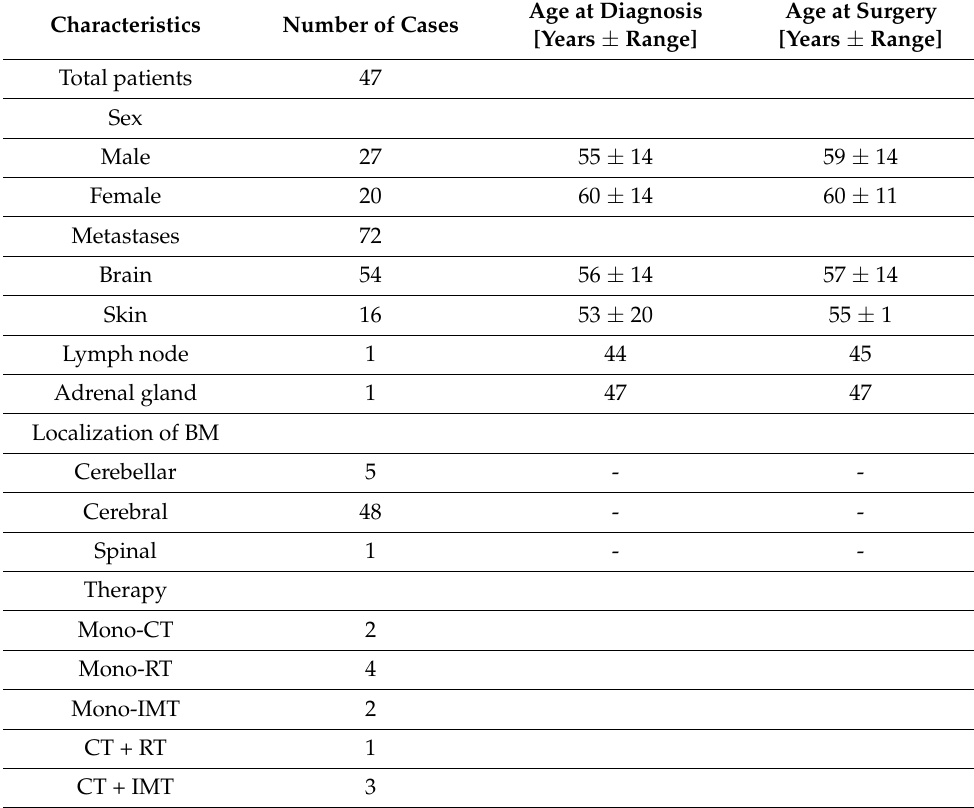
Table 1. Patient